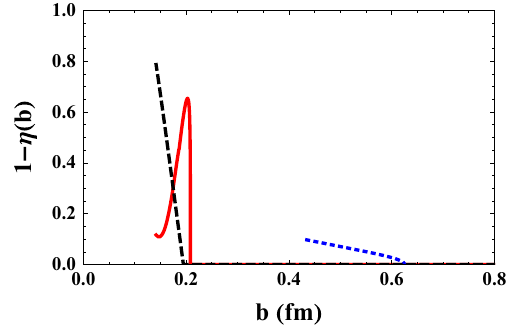
Fig. 10 Inelastic profile as a function of the impact parameter b = ( l + 1 / 2 )/ p for the S0 (full, red), P (dotted, blue) and S2 (dashed, black) waves when the maximum CM energy becomes